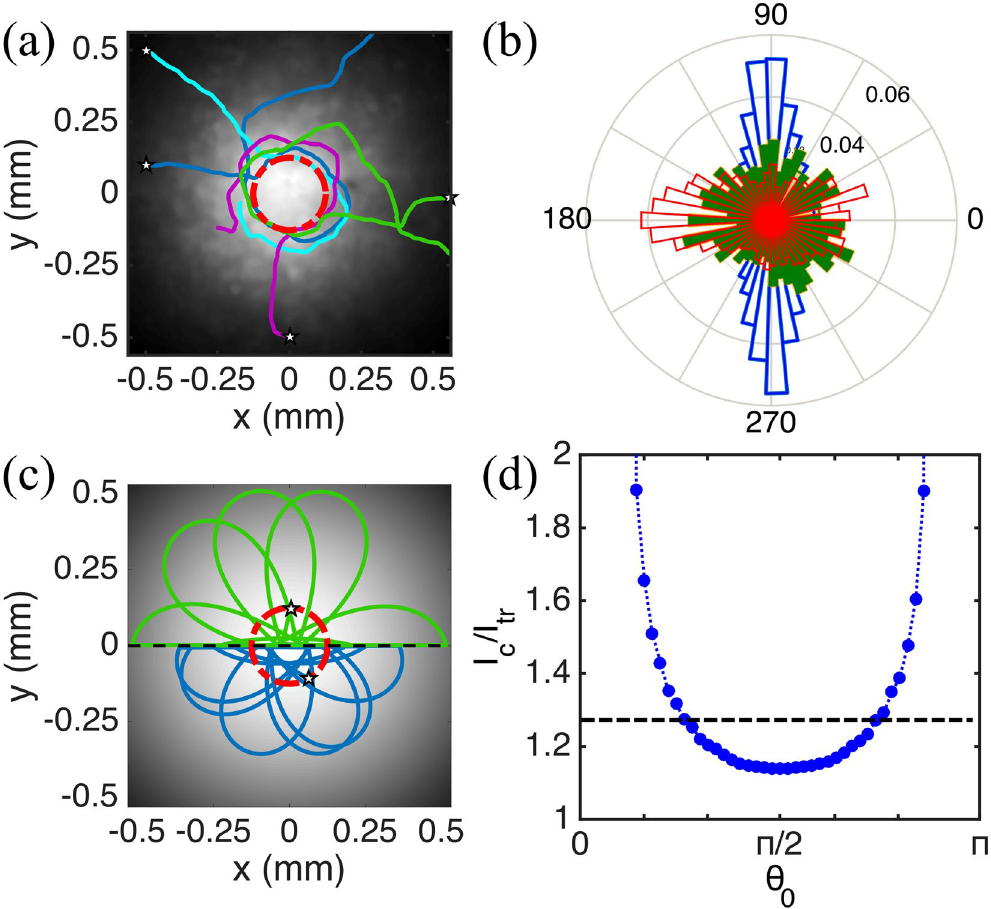
Figure 1. Single cell phototaxis of C. reinhardtii . ( a ) Sample trajectories, starting at the star-marked points. Cells approach the centre of the light field, circulate around it at an average distance ρ c marked by the red dashed circle, and then leave the field of view. ( b ) Experimental histograms of cells’ directions at ρ = 78 μ m (green), 156 μ m (blue), and 780 μ m (red). The angle is oriented radially outwards. ( c ) Representative trajectories from local gradient model, with α = α max , starting at ρ = ρ c with initial orientations θ = 205° (blue) and 162° (green). For clarity, only half of each trajectory is displayed. Red dashed circle has radius ρ c . The underlying light field is the best Gaussian fit to the experimental one. ( d ) Ratio between the average light intensity seen by a swimmer circulating at ρ = ρ c and moving along trochoidal trajectories starting at ( ρ c , θ 0 ) (blue circles; dotted line: guide to the eye). Black dashed line: average value of the relative increase in irradiance